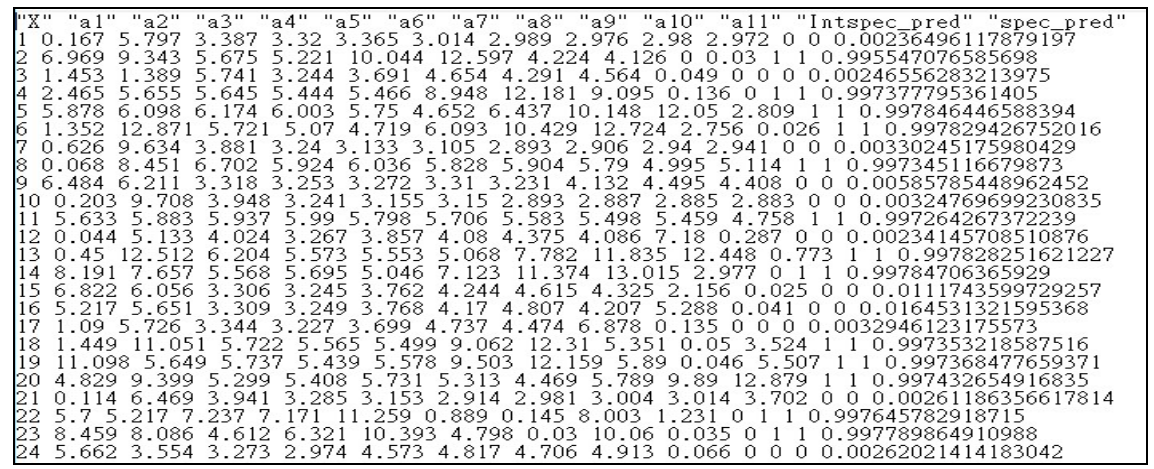
Figure 7. The prediction results derived from the model are transferred into text file. Table 3. Correction rates of the predictive model.